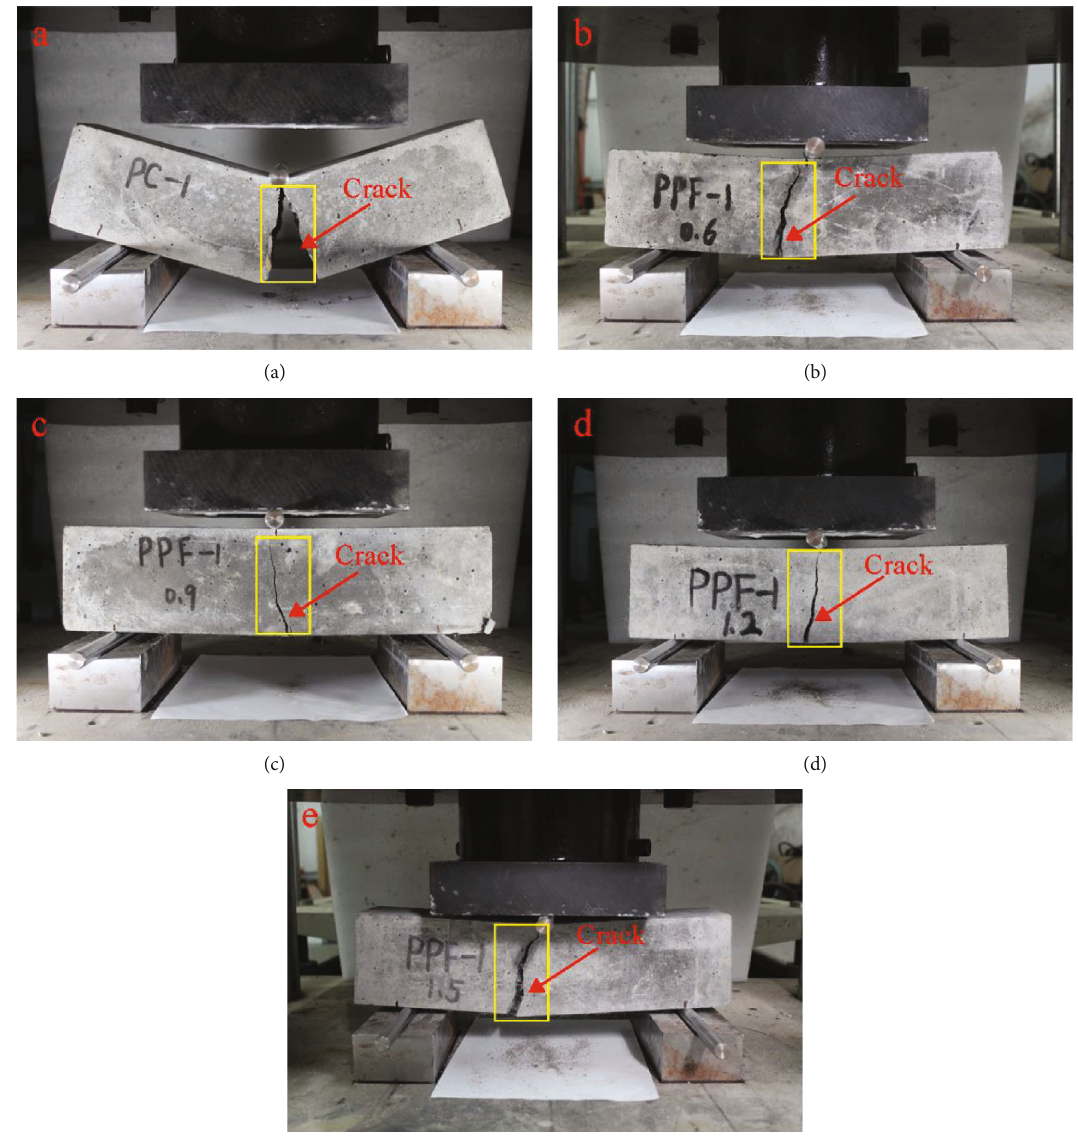
Figure 23: PC and PPFRC failure type: (a) PC (brittle) and (b ~ e) PPFRC